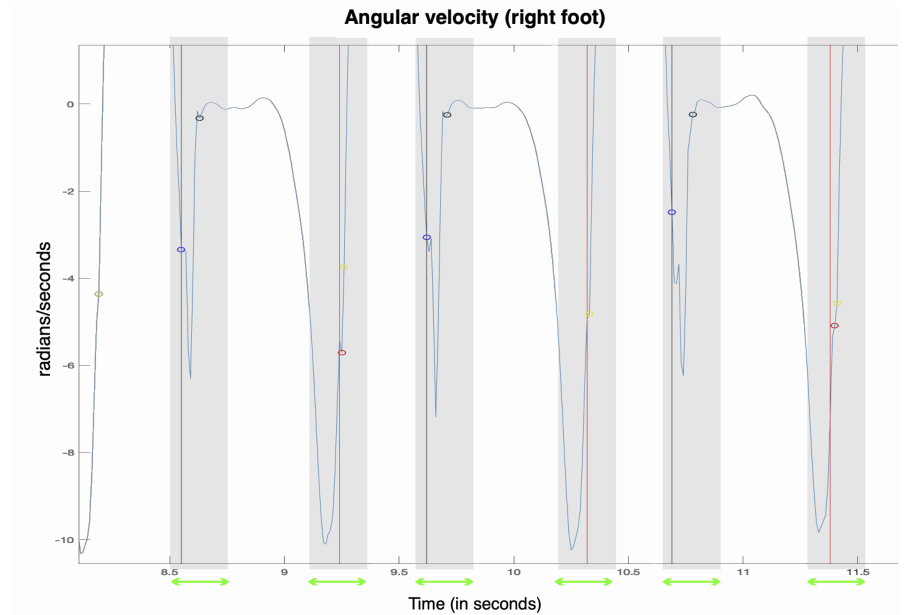
Figure 7. Around each step detected by template-matching, a 2 × z samples-sized area (green arrows, grey zones) is scanned (in this case, z = 10) and DTW distances are computed for each one of these samples. The black and red points correspond to the IC and FC instants predicted by template matching. The blue and yellow points correspond to the IC and FC instants detected after the DTW refinement step. The black and red lines correspond, respectively, to the IC and FC of the step, as annotated by the GR